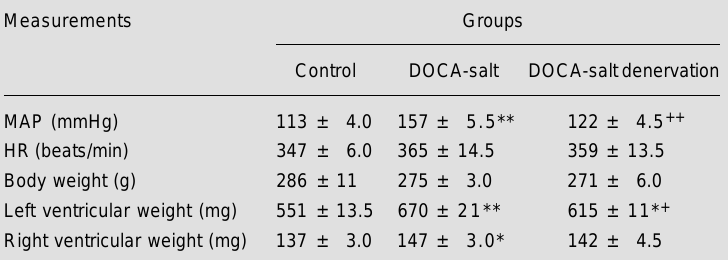
Table 1 - Influence of renal denervation on cardiovascular parameters of uninephrectomized Wistar rats with or without DOCA-salt treatment. The measurements were performed after 15 days of DOCA-salt treatment. The groups of rats studied were: sham-denervated with vehicle treatment (control, N = 9), sham-denervated with DOCA-salt treatment (DOCA-salt, N = 11) and denervated with DOCA-salt treatment (DOCA-salt denervation, N = 9) groups. Values are reported as the mean ± SEM. * P<0.05 and **P<0.01 compared to control group values; + P<0.05 and ++ P<0.01 compared to DOCA-salt group values Measurements